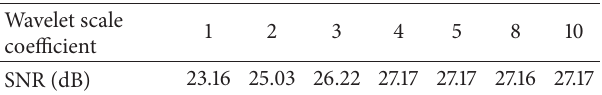
Table 6: The SNR results of rotation speed with different wavelet scale coefficient (dB).